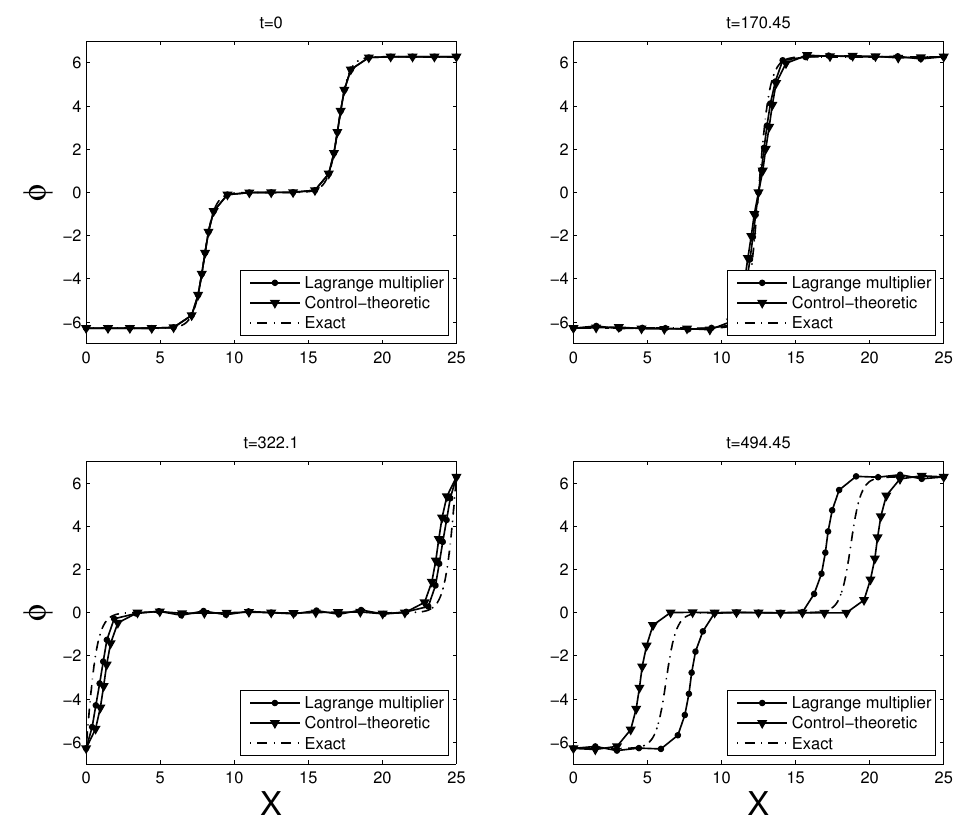
Figure 12. The two-soliton solution obtained with the control-theoretic and Lagrange multiplier strategies for N = 25. Integration in time was performed using the 4th-order Gauss quadrature for the control-theoretic approach and the 4th-order Lobatto IIIA–IIIB quadrature for constrained mechanical systems in case of the Lagrange multiplier approach. The solitons initially move towards each other with the velocities v = 0.9, then bounce off of each other at t = 5 and start moving towards the walls, from which they bounce at t = 18.79. The solitons bounce off of each other again at t = 32.57. This solution is periodic in time with the period T period = 27.57. The nearly exact